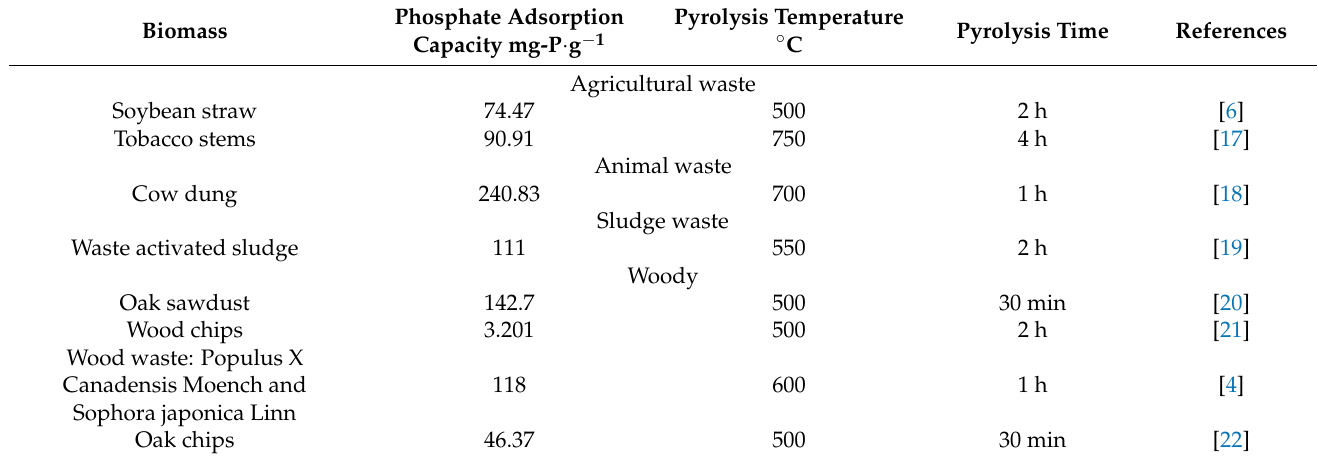
Table 1. Sources of biomass used for the synthesis of biochar for the adsorption of phosphate, pyrolysis temperature and